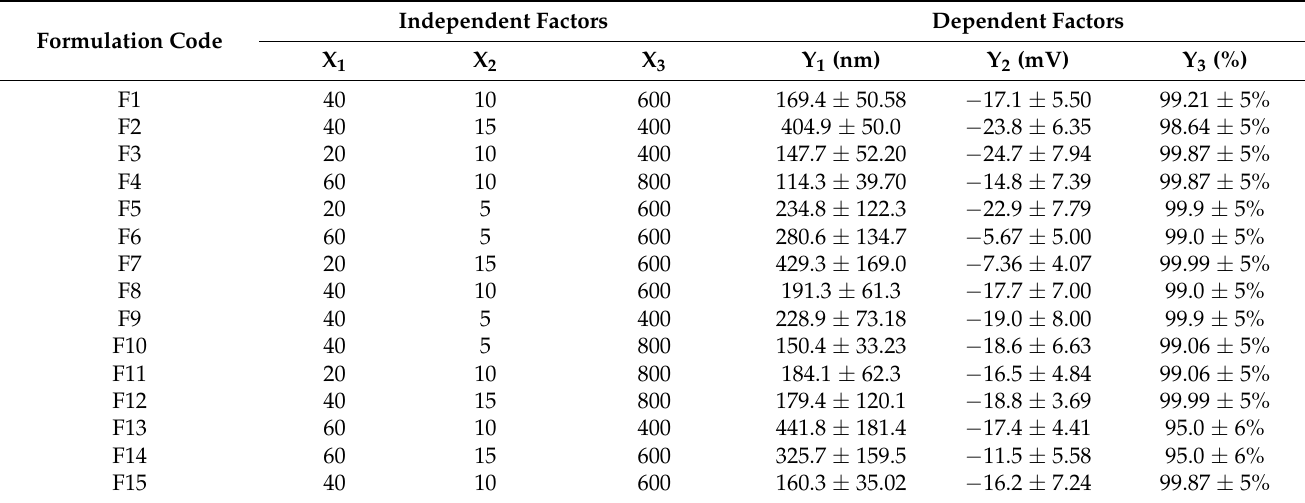
Table 2. Composition matrix and the observed values of the prepared FLZ-nanoparticles based on the Box-Behnken